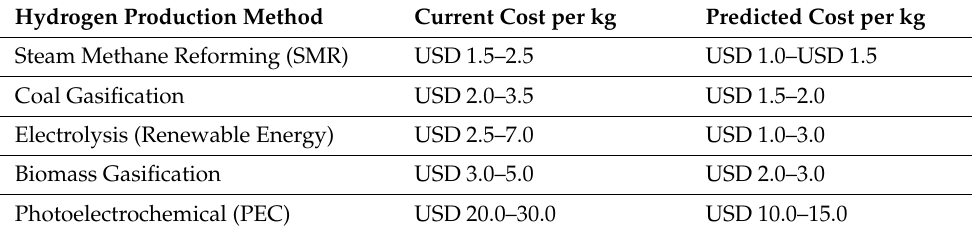
Table 1. Predicted cost per kg of hydrogen for each